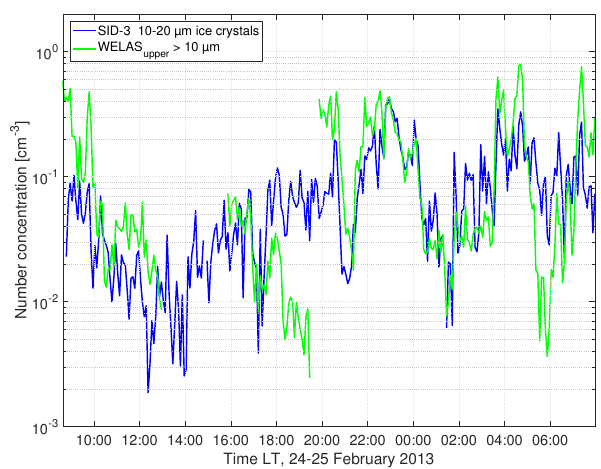
Figure 10. Comparison of the number concentrations of cloud par- ticles >10µm optical diameter D opt measured by the upper WE- LAS (green line) and ice crystals with optical diameters D opt of 10–20µm (blue line) measured by the SID-3 on 24–25 February